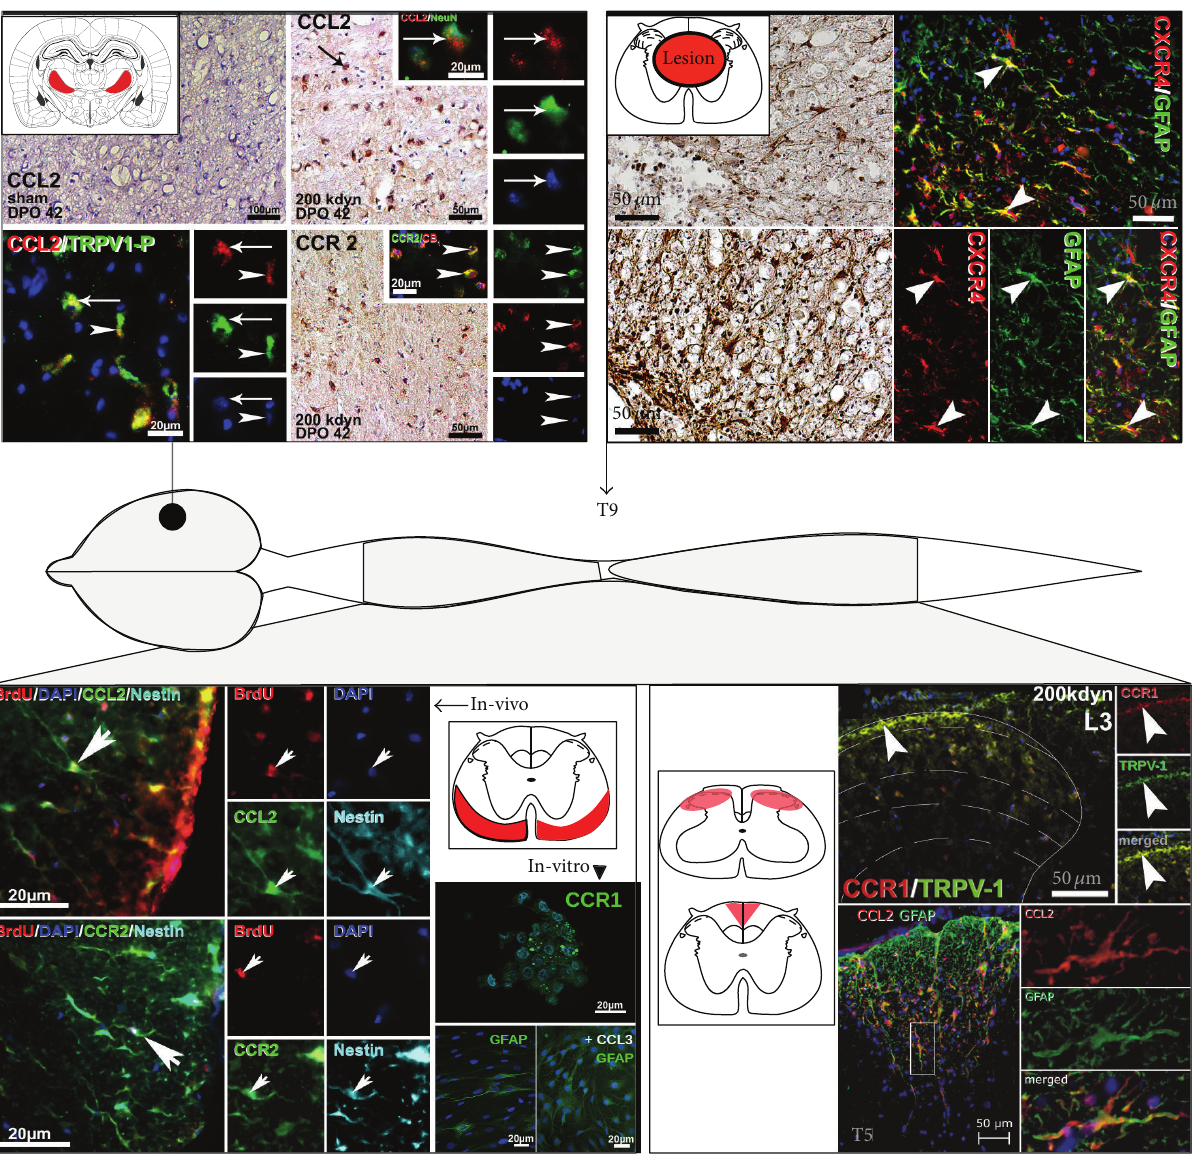
Figure 2: Chemokine-ligand/receptor-expression after impact SCI in adult rats. After impact lesions, different chemokines are induced in distinct anatomical regions along the whole neuraxis. This overview exemplarily illustrates chemokine-ligand/receptor-immunostaining along the neuraxis (diaminobenzidine and double/triple-immunofluorescence labeling). Schemes indicate anatomical location. On brain level, CCL2/CCR2 expression was found induced in thalamic nuclei in the late time-course, that is, 42 hours after severe SCI, which was colocalized with TRPV1 and CB1. Sham animals did not exhibit chemokine expression in this location. On lesion level T9 chemokine- ligands/receptors were induced in inflammatory cells in the early and astroglial cells in the later time-course. Furthermore, chemokines were induced in the ventrolateral white matter along the whole spinal cord. Here, chemokines colocalized with proliferating BrdU-labeled cells, which coexpressed astroglia and NPC markers (shown for nestin). In vitro, CCR1 was found consistently expressed on endogenous NPCs (demonstrated for a sham-derived neurosphere). Applying CCL3 to NPCs during differentiation cycles led to significant higher GFAP- mRNA and immunohistochemical level as compared to untreated neurosphere cultures (demonstrated for sham-derived cultures). Another anatomical location of chemokine induction was pain-related spinal cord areas like dorsal horns and dorsal columns. Here, chemokine expression colocalized among others with TRPV1 and glial markers. Details are discussed in the respective sections.